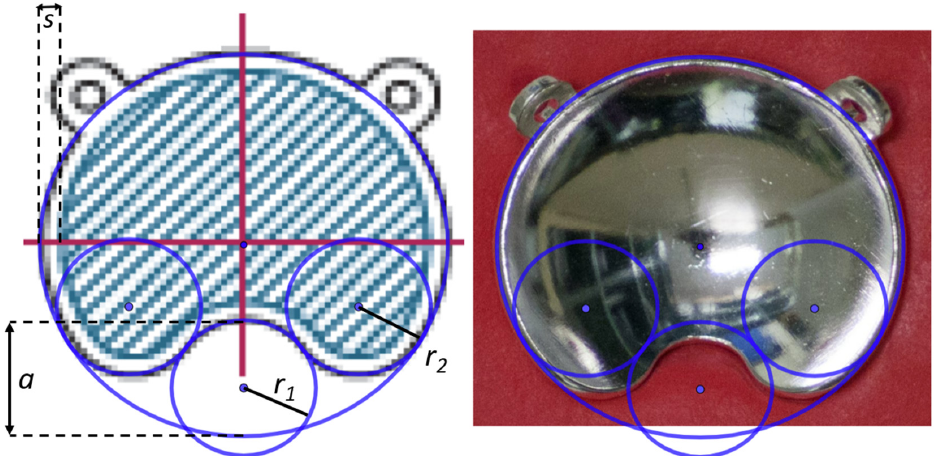
Figure 1. Images generated with GeoGebra of the COB plaque type with the superposition of the geometric forms that characterize the cutout using the parameter values given by the manufacturer ( a , r 1 , and r 2 ). The size of the inactive rim is represented by the parameter s . ( Left ) Plaque diagram extracted from the user manual, where the hatched area represents the active region. ( Right ) Image of a photograph taken for this work.